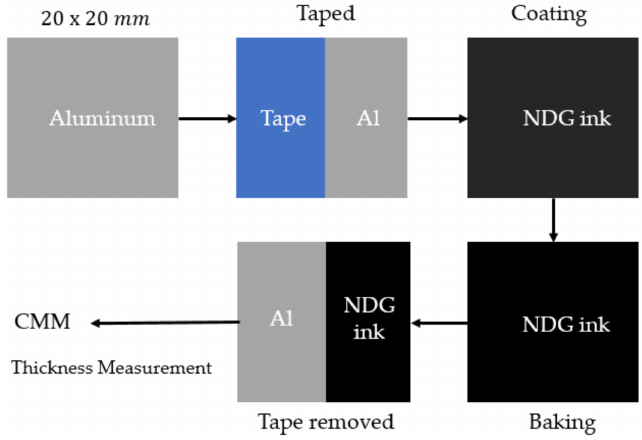
Figure 10. Test specimen preparation for the resistance measurements.